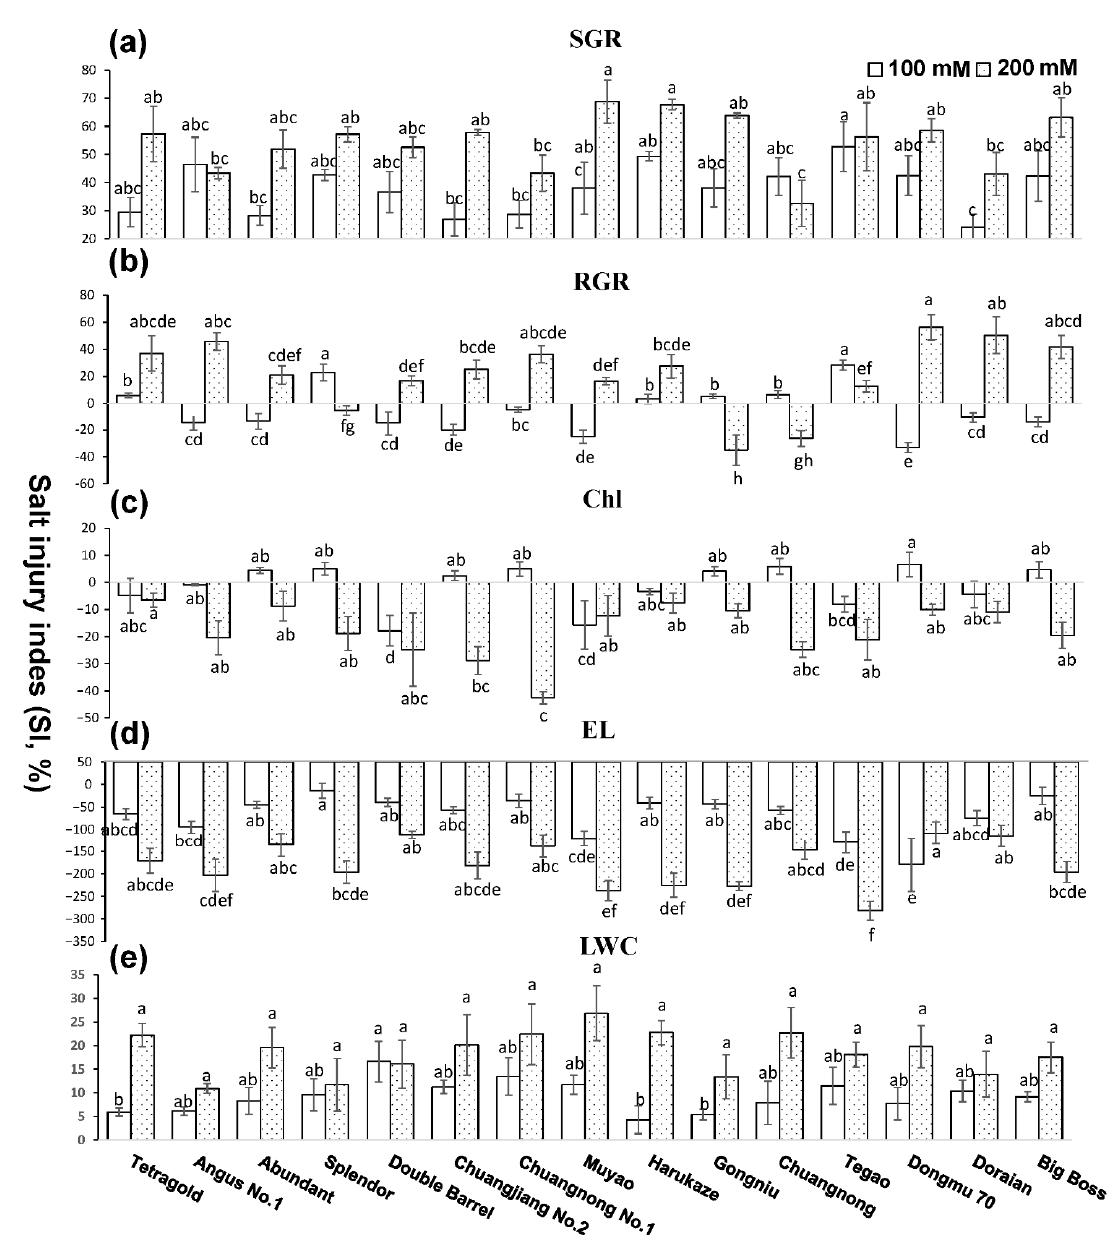
Figure 3. The salt injury index (SI) for each cultivar under different NaCl treatment; ( a ) the SI for shoot growth rate (SGR); ( b ) the SI for root growth rate (RGR); ( c ) the SI for chlorophyll content (Chl); ( d ) the SI for electrical conductivity (EL); ( e ) the SI for leaf relative water content (LWC). Error bars are ± standard deviation. Columns marked by the same lower-case letters for a given NaCl concentration are not significant at p < 0.05 (Tukey’s test) for the comparison of different